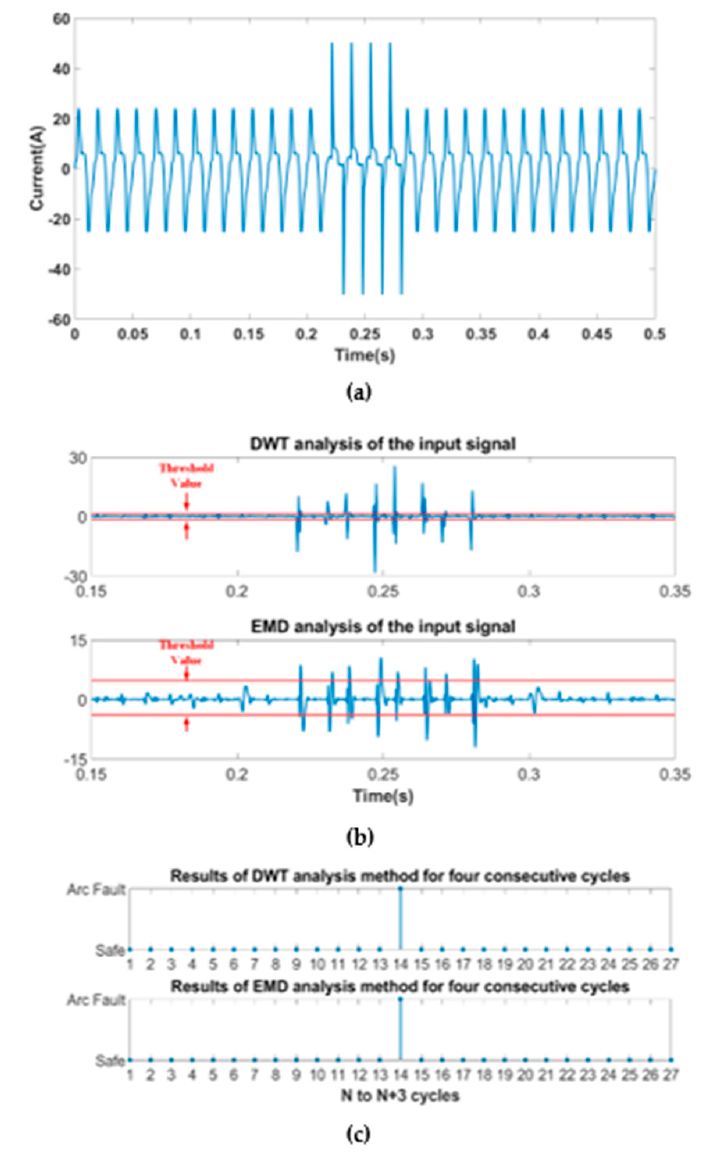
Figure 16. Series arc fault detection results of the mixed load ( a ) input current signal ( b ) DWT and EMD analysis signals, and ( c ) the detection result of each method.